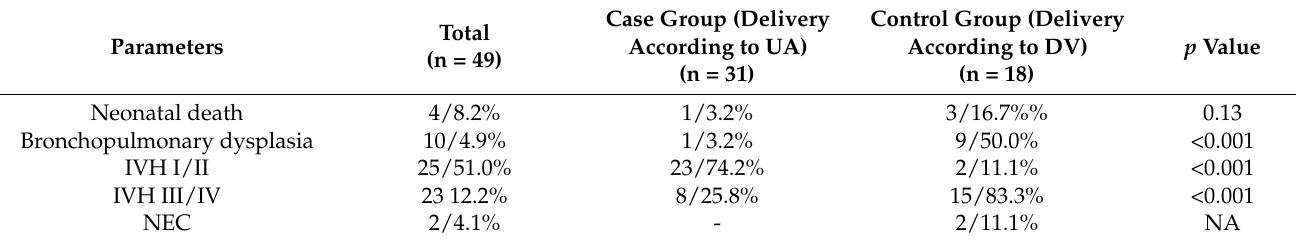
Table 4. Adverse fetal outcomes in infants born at less than 30 weeks.